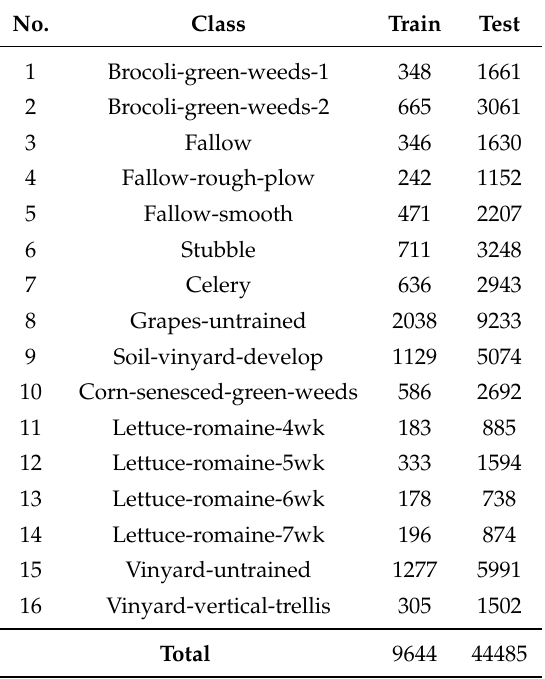
Table 3. The number of training and testing samples for the Salinas